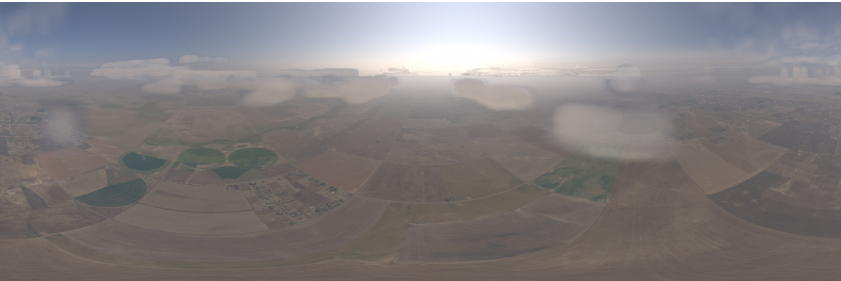
Figure 7. In situ panoramic view in the lower troposphere showing smoke aerosols and hydrometeors. This is part of an animation simulating an airplane landing at Denver International Airport. The panorama spans 360 ◦ from a perspective ∼ 4km above ground. Hydrometeor fields are from a Local Analysis and Prediction System analysis.